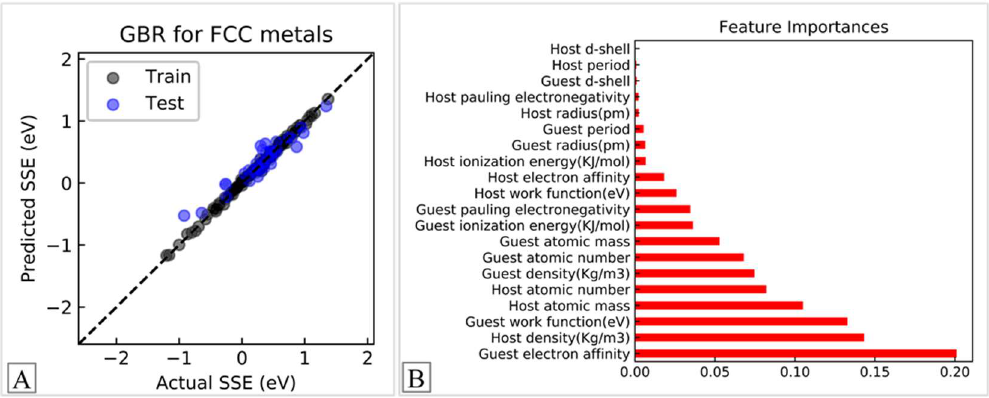
Figure 2. ( A ) Model predictions and ( B ) Feature importance scores for FCC(111) surfaces obtained from GBR model. SSE = surface segregation energy. Table 2. Root mean square error (RMSE), mean absolute error (MAE) and R 2 values for training and test sets obtained from gradient boosting regression (GBR) model using 20 features. Training Set Test Set